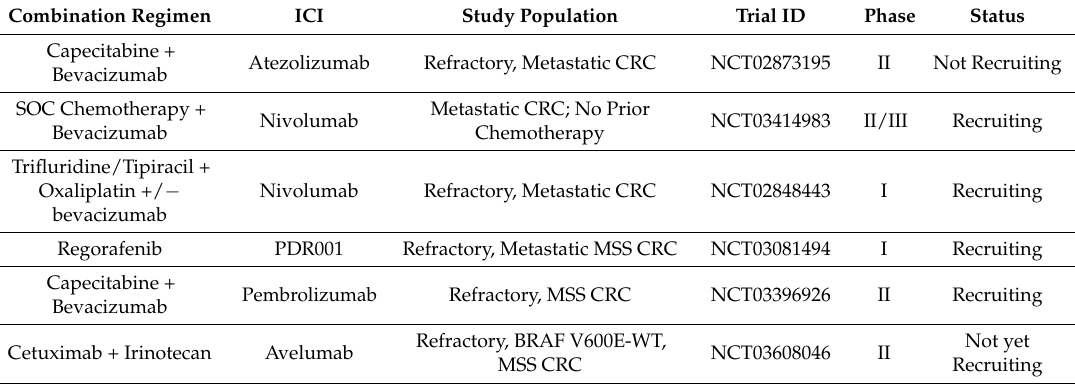
Table 2. Selected clinical trials of ICIs in combination with molecularly targeted agents in patients with